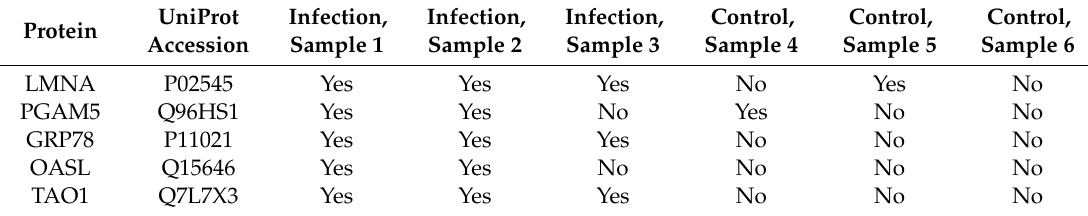
Table 1. Potential interactors of Zika virus (ZIKV) envelope (E) identified by proteomic analysis. Protein